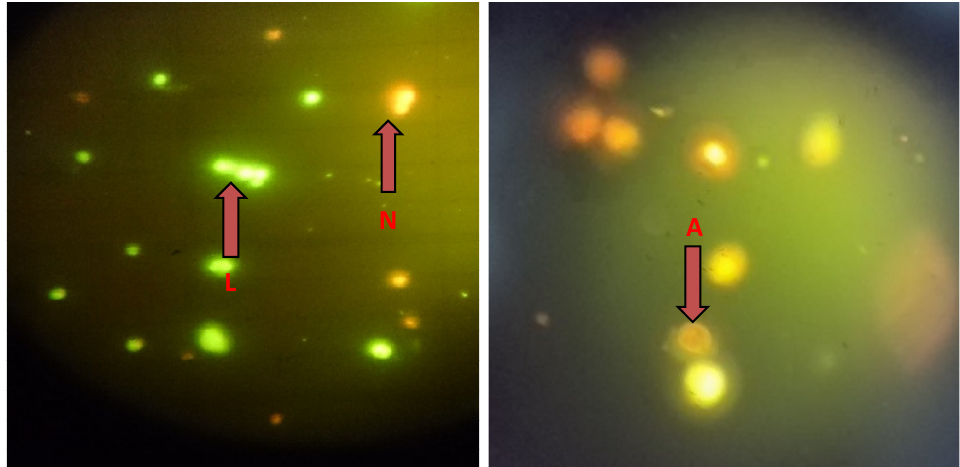
Fig. 5. Fluorescent microscope images of HT-29 cells after staining with acridine orange and ethidium bromide. In these images, L is living cells, N is necrotic cells, and A refers to cells with secondary apoptosis .